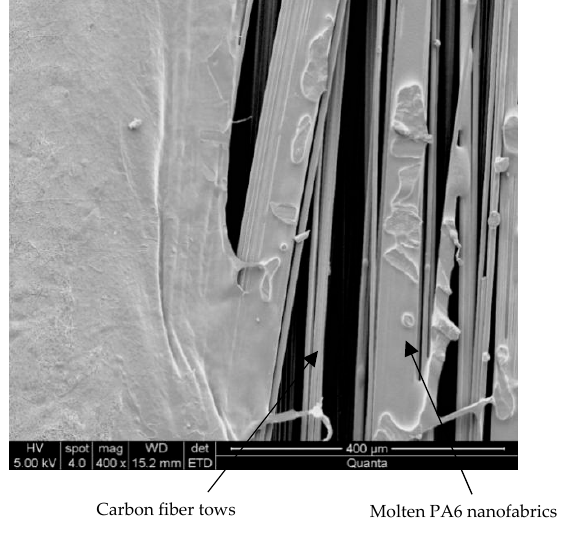
Figure 11. ( a ) SEM image of the weld. ( b ) Magnification of the dotted area. Circles in ( b ) indicate areas of molten nanofabric coating the carbon fiber tows.